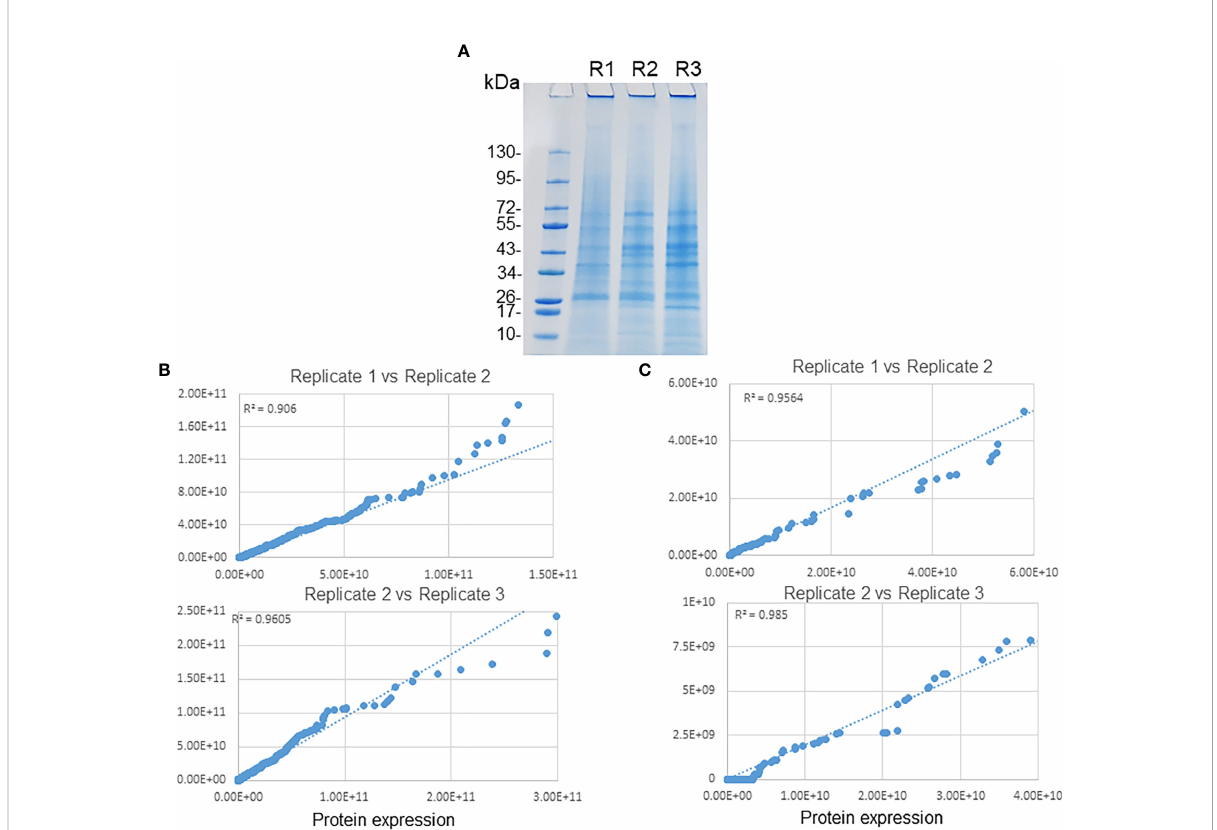
FIGURE 1 Replicates of phagosome membrane proteins of E . chaffeensis . (A) Puri fi ed phagosome membranes from three replicate samples were separated by SDS-PAGE followed by staining with colloidal blue stain. Scatter plots for the protein expression data comparison of replicate samples. Proteins associated with host phagosome membranes (B) and E . chaffeensis (C) among replicates revealed a higher degree of